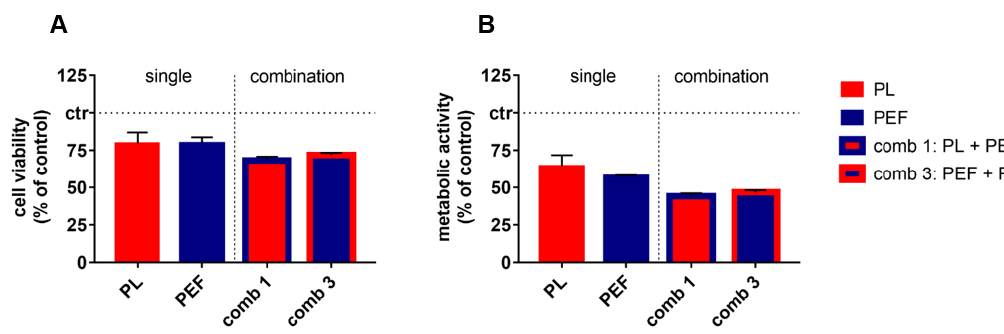
Figure 8. Cell viability and metabolic activity of U937 24 h after single and combination treatments. The plasma exposure time was 40 s, and the electric field strength was 1.25 kV / cm. The cell viability ( A ) was detected using CellEvent Caspase 3 / 7 Green Detection Reagent and sytox blue dead cell stain, and compared to the metabolic activity ( B ) determined using the resazurin assay. For a comprehensive overview, the statistical analysis is laid out below (Table 5). Data are shown as mean + S.E. of two independent experiments. PL = plasma; PEF = pulsed electric fields; comb = combination. Table 5. Statistical analysis of cell viability and metabolic activity 24 h after treatment. A multiple t-test was performed (* p < 0.05; ** p < 0.01; and *** p < 0.001). ctr = control; PL = plasma; PEF = pulsed electric fields; comb = combination; n.s. = not